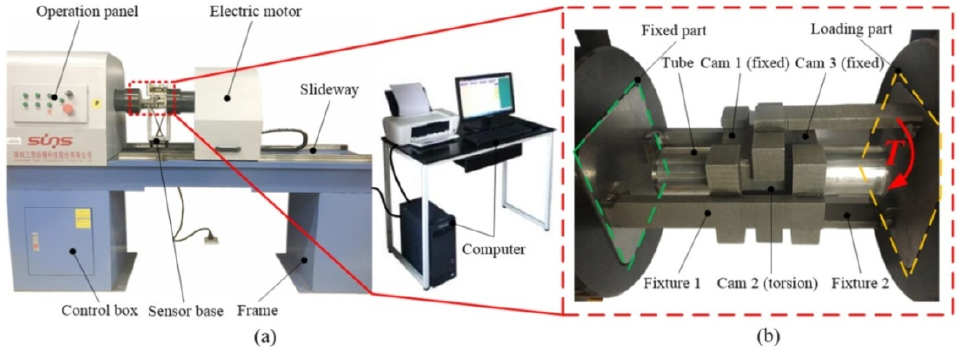
Figure 3. Orthogonal torsion experiment equipment for assembled camshafts [28]: ( a ) TTM502-A1 electronic torsion test rig and ( b ) detailed view. Table 3. Factors and levels of orthogonal torsion experiment.